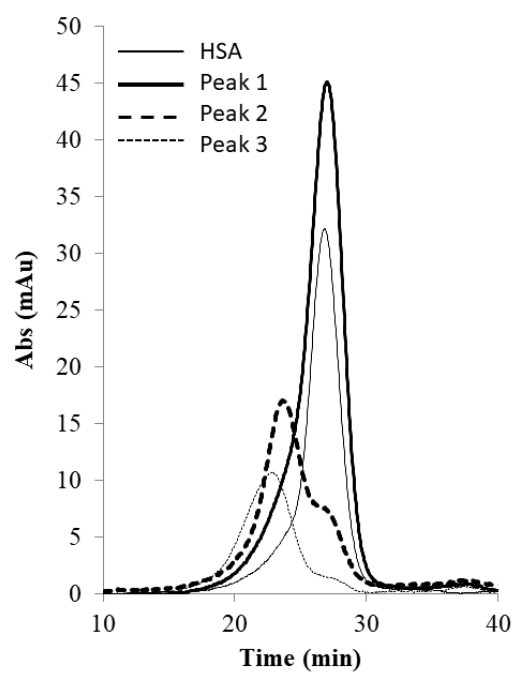
Figure 10. SEC chromatograms of samples obtained by tangential flow-filtration-based hybrid separation (peak 1: 1.65 M flow-through, peak 2: 1.5 M eluate, peak 3: 0 M eluate).